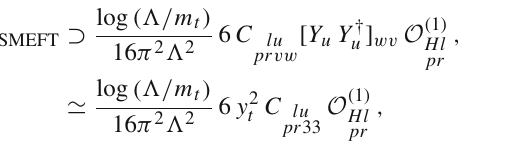
O ( 1 ) couplings can produce a O ( 10% ) deficit in R agreement with the latest R K measurement by LHCb